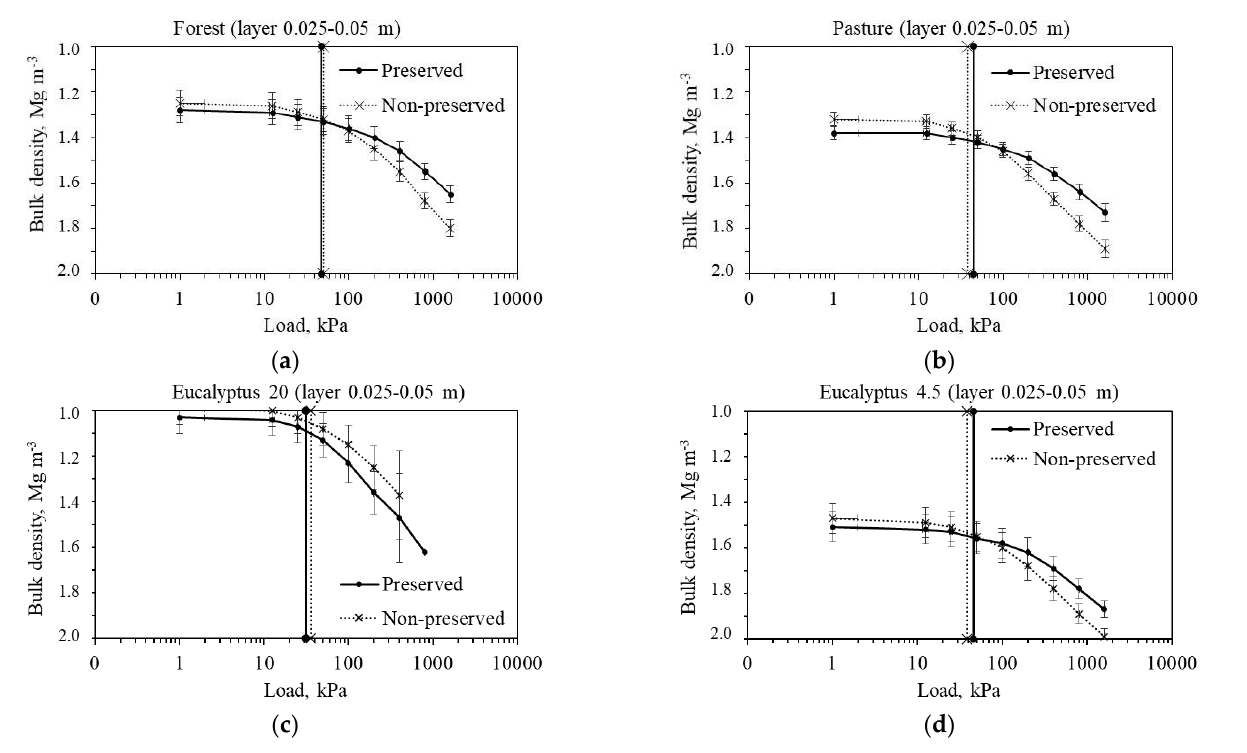
Figure 2. Soil compression curve for soil with preserved and non-preserved structure in the 0.025–0.05 m soil layer for four land uses. Vertical error bars for each pressure indicate the least significance difference, while vertical bars that accompany the superior and inferior axes in the figure indicate the precompression stress value for the preserved and non-preserved soil structures.